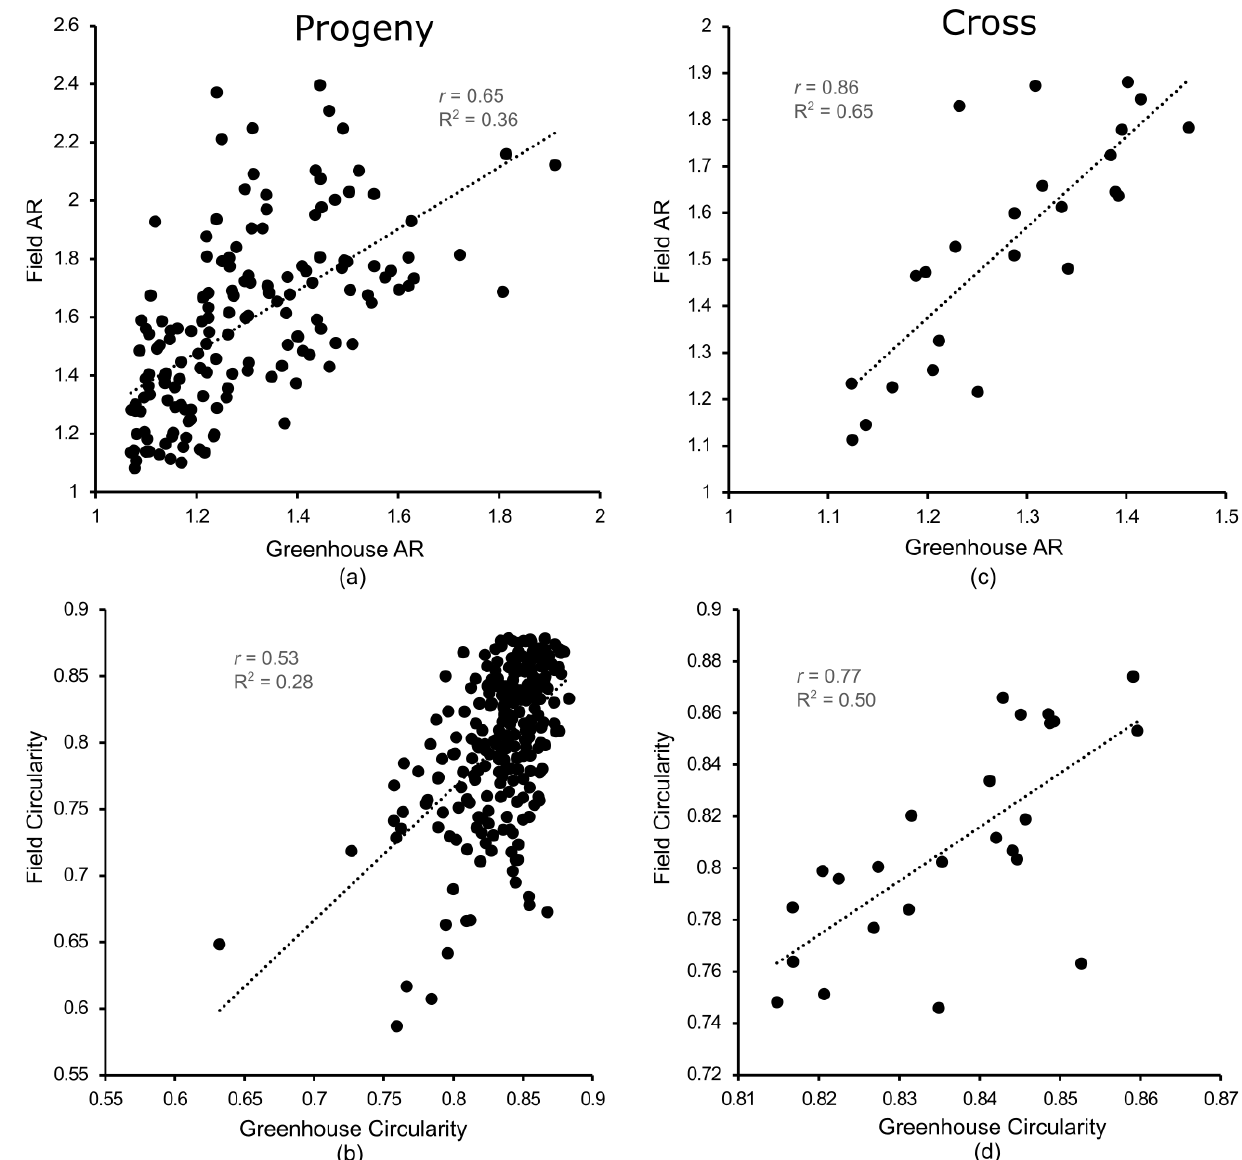
Figure 3. Greenhouse versus field grown tuber shape properties. ( a ) progeny AR, ( b ) progeny circularity, ( c ) cross AR, ( d ) cross circularity.